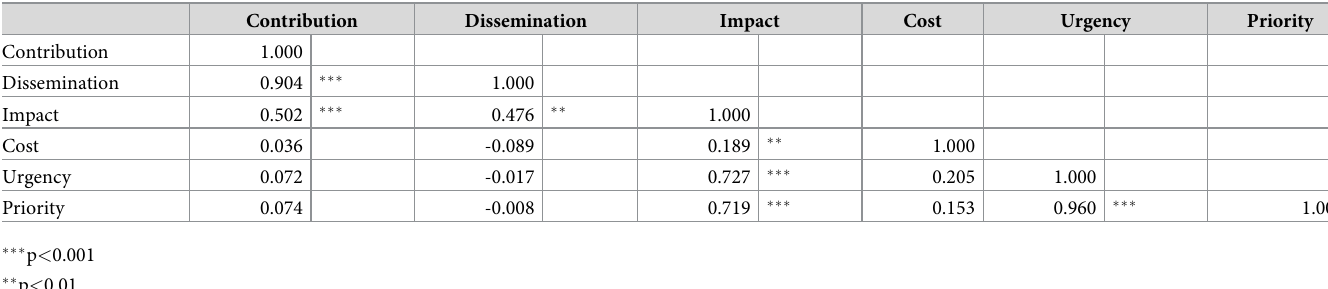
Table 6. Correlation between the six perspectives (Spearman’s correlation coefficients).